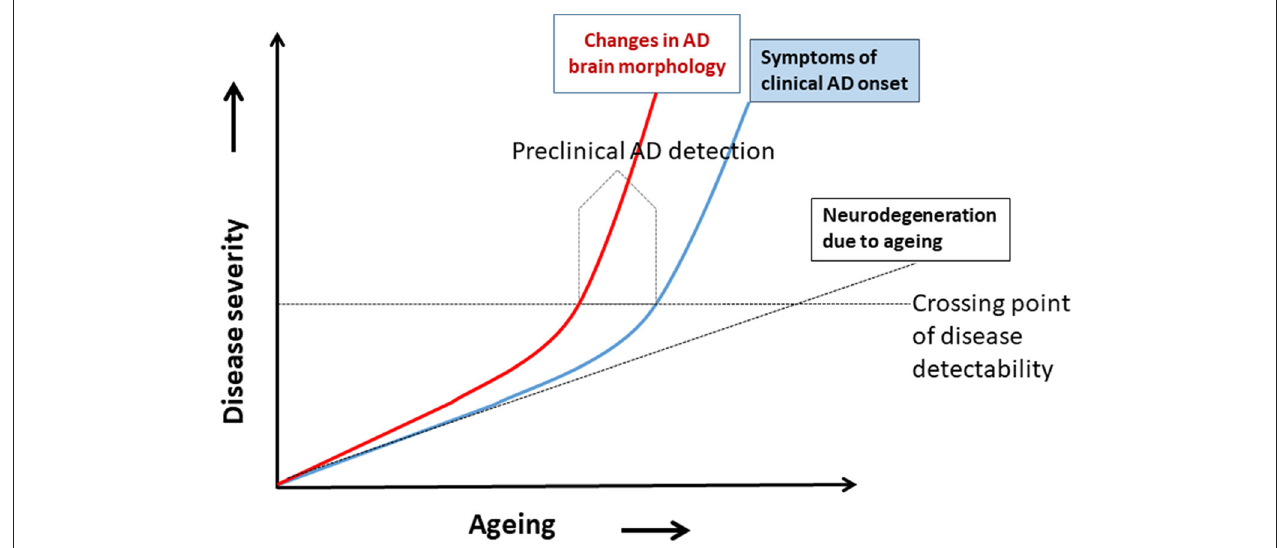
FIGURE 1 | A hypothetical model for detecting preclinical Alzheimer’s disease (AD). Disease severity increases with aging, the major risk factor for an AD. Two disease trajectories represent brain morphology changes (red) and clinical AD symptoms (blue). Neurodegeneration due to aging shown by the broken black line. The model shows the hypothetical deviation of the changes in brain morphology trajectory and symptoms trajectory, and where they cross a horizontal line of disease detectability. The preclinical AD can be detected before the onset of AD symptoms (modified from Khan,